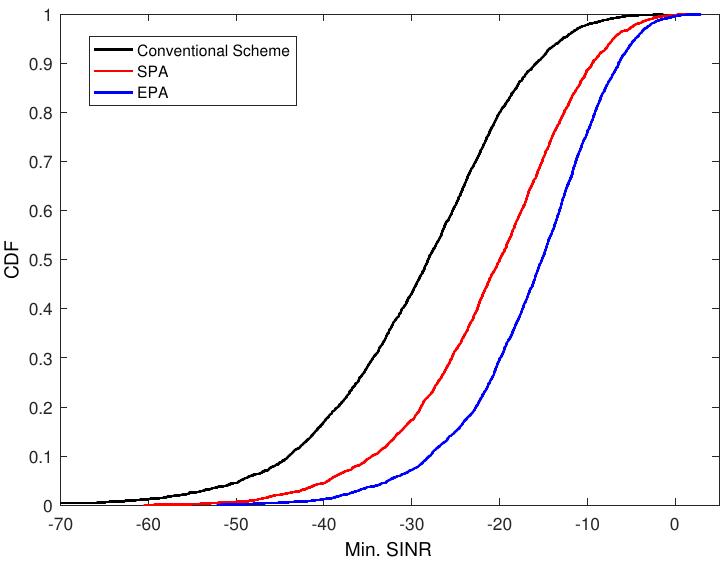
Figure 8. The CDF of the min. SINR when M = 64 using